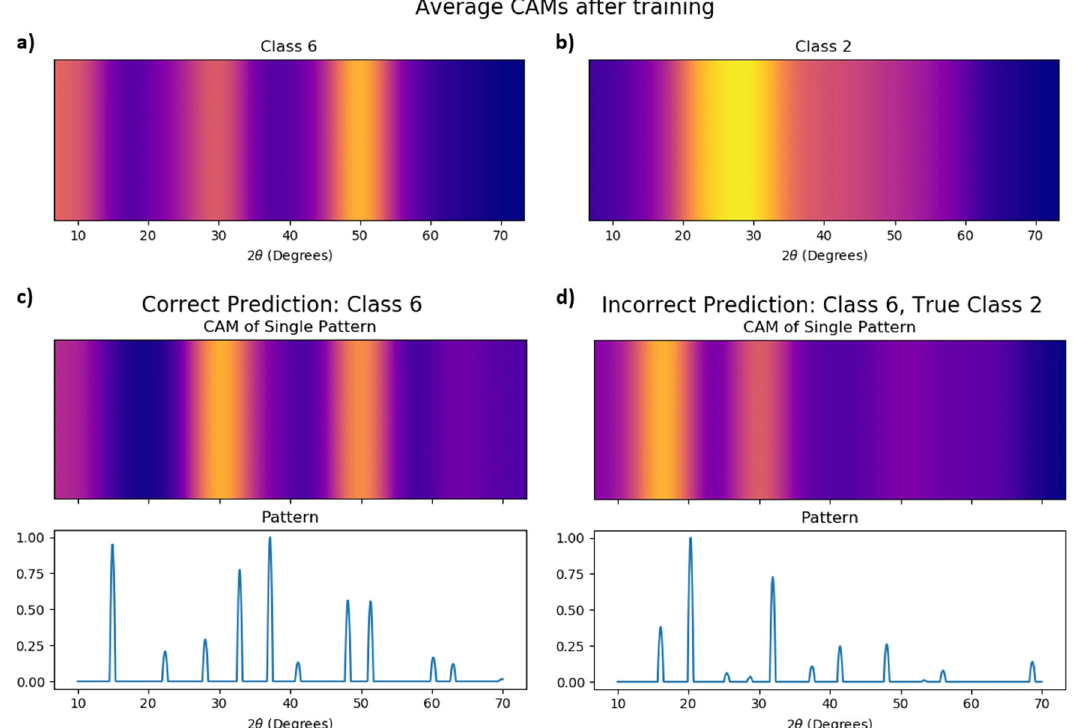
Fig. 4 Example heat map explanations for a CNN with spectral input. The task is to predict sample space groups from XRD spectral. a , b Averaged CAM heat maps of space group Class 2 ( P 2 1 / a ) and Class 6 ( Pm 3 m ). c , d CAM heat map and input spectrum of a correctly classi fi ed sample and an incorrectly classi fi ed sample. Comparing the heat map explanation of each prediction ( a , b ) to the average heat map explanation of each class ( c , d ) helped the authors identify the root cause of model mistakes. Figure reprinted from ref. 22 under the CC BY 4.0 license 156 .